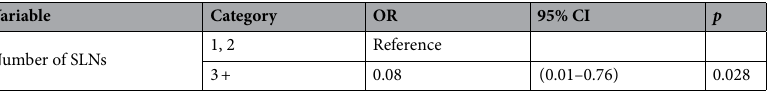
Table 4. Impact of detected SLN on false-negative results. The number of SLNs was included in a logistic regression model as a covariate. Propensity score analysis and inverse probability weighting were used to adjust the influence of clinical factors. A propensity of detection of three or more SLNs was assessed by logistic regression using age, sex, primary site, primary resection, pT, SPECT/CT, shine-through, and gamma-probe as covariates. OR: Odds ratio; CI: Confidence interval; SLN: sentinel lymph nodes.